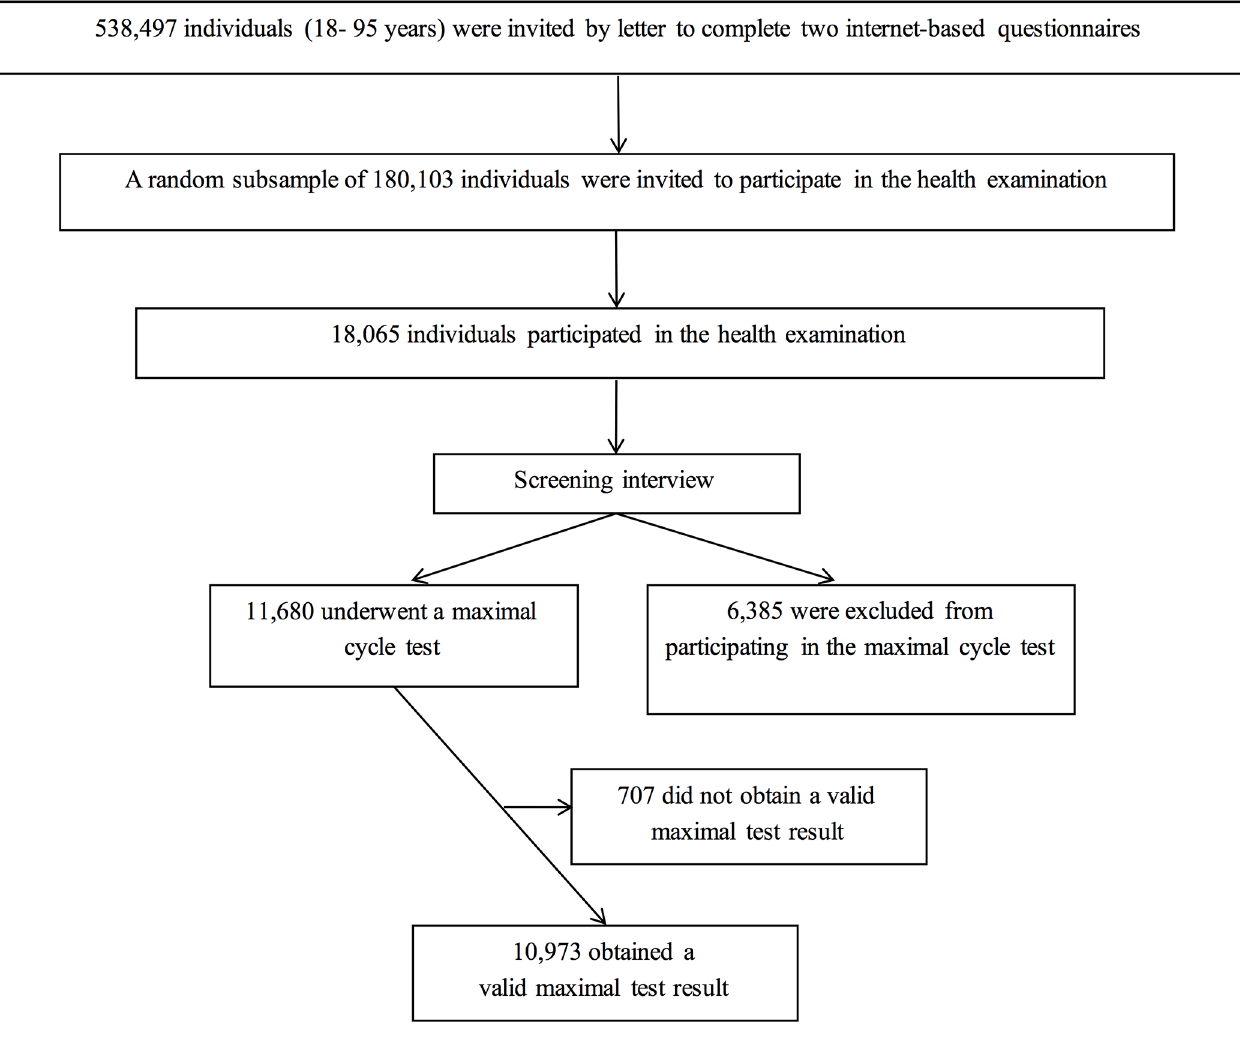
Fig 1. Selection of